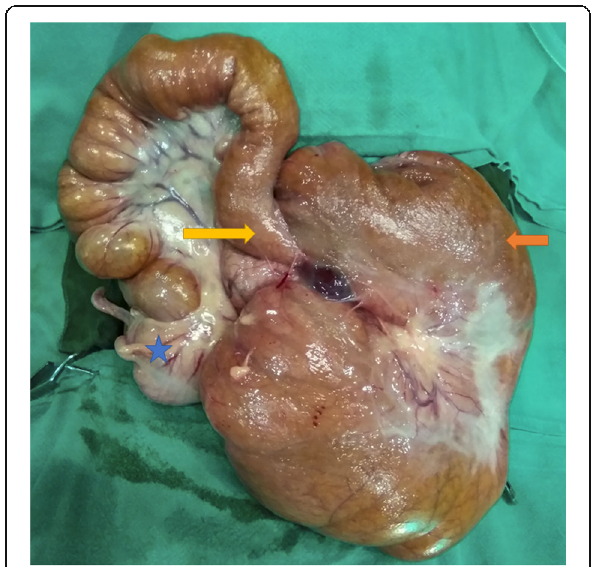
Fig. 1 Operative findings showing hugely dilated segment of ileum (orange arrow), abrupt dilatation (yellow arrow suggesting normal distal bowel), and caecum (indicated by blue